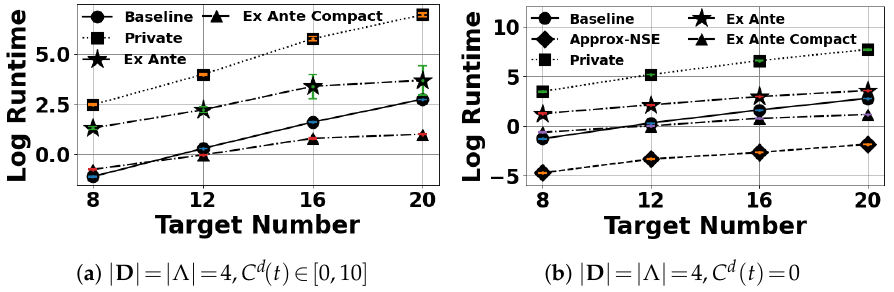
Figure 5. Log run time in